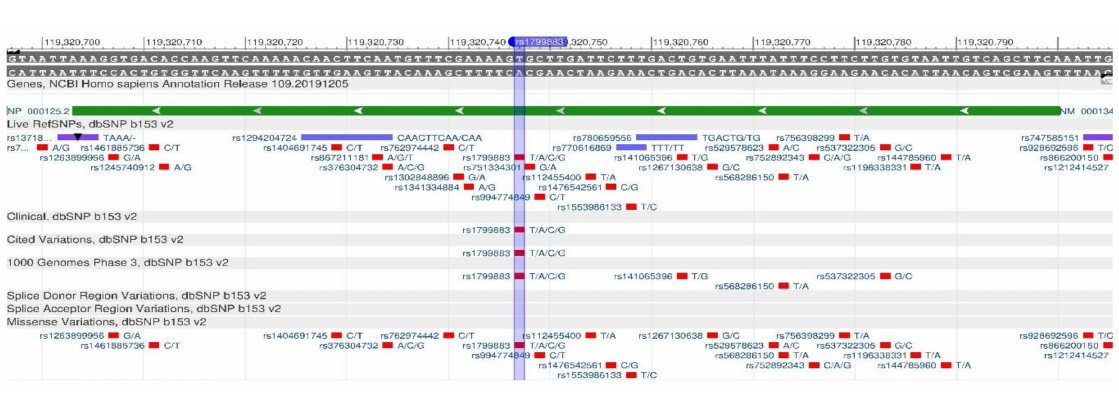
Figure 5. A plot of the FABP2 gene (located on the long (q) arm of chromosome 4) containing the oligonucleotide polymorphism rs1799883.